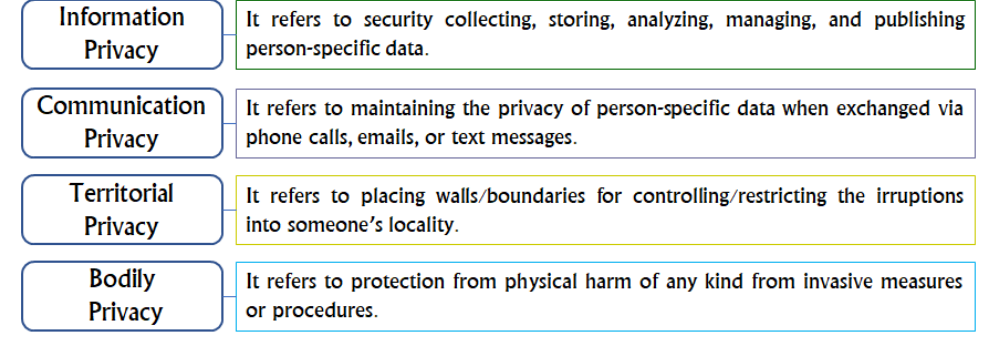
Figure 5. Classification of the scope of